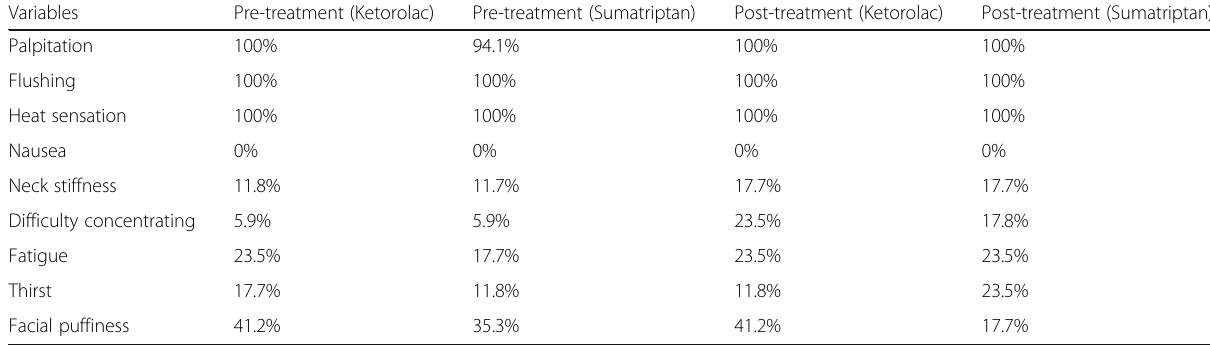
Table 2 Adverse events after PACAP38 infusion and treatment with ketorolac and sumatriptan